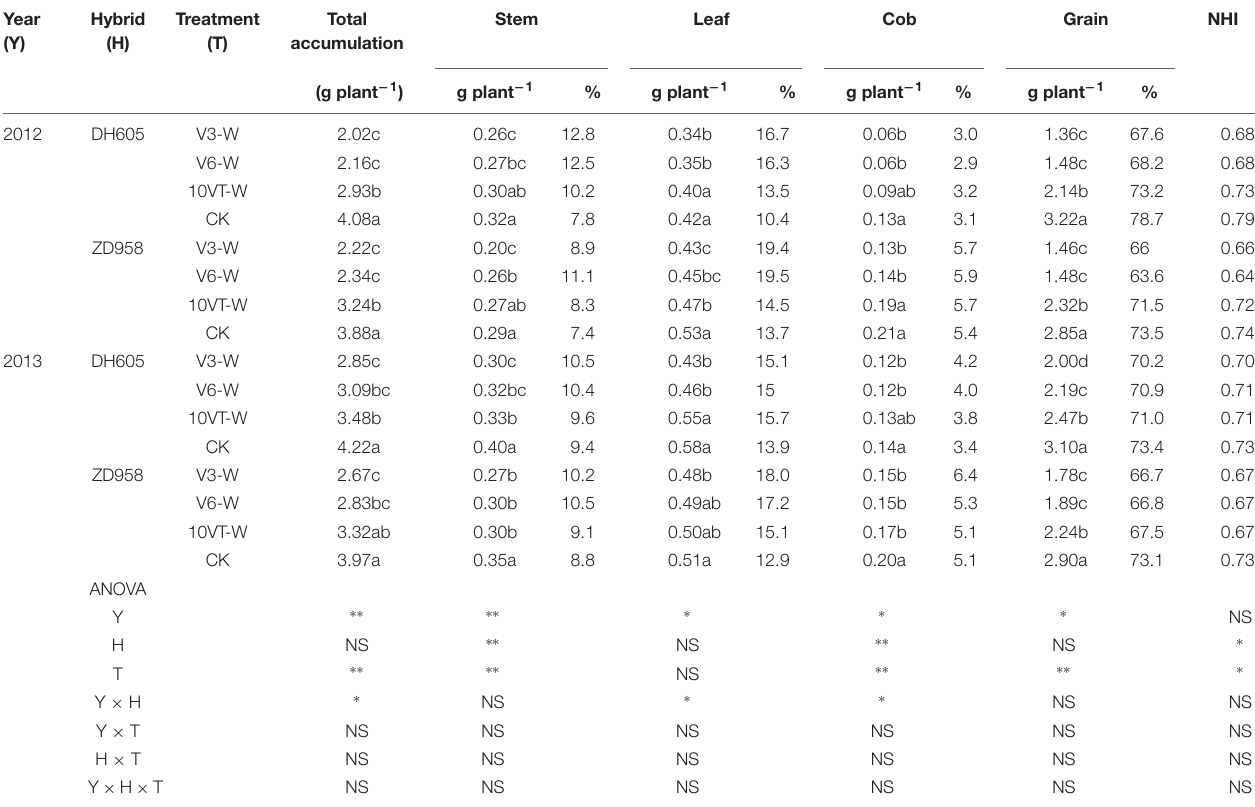
TABLE 1 | Effect of waterlogging on N accumulation (g plant − 1 ) and distribution (%) of maize at maturity